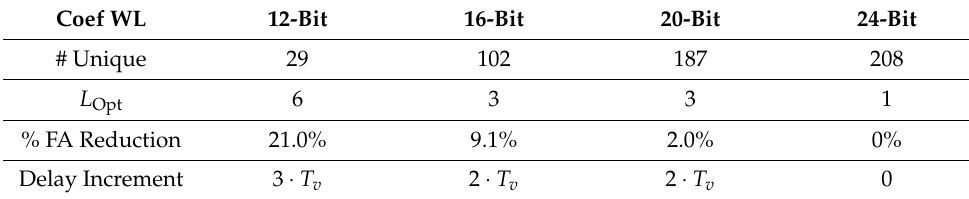
Figure 9. Total FA cost of four 418-tap filters with different coefficient word-lengths for different L values. Table 2. Results for 418-tap filters with different word-lengths.